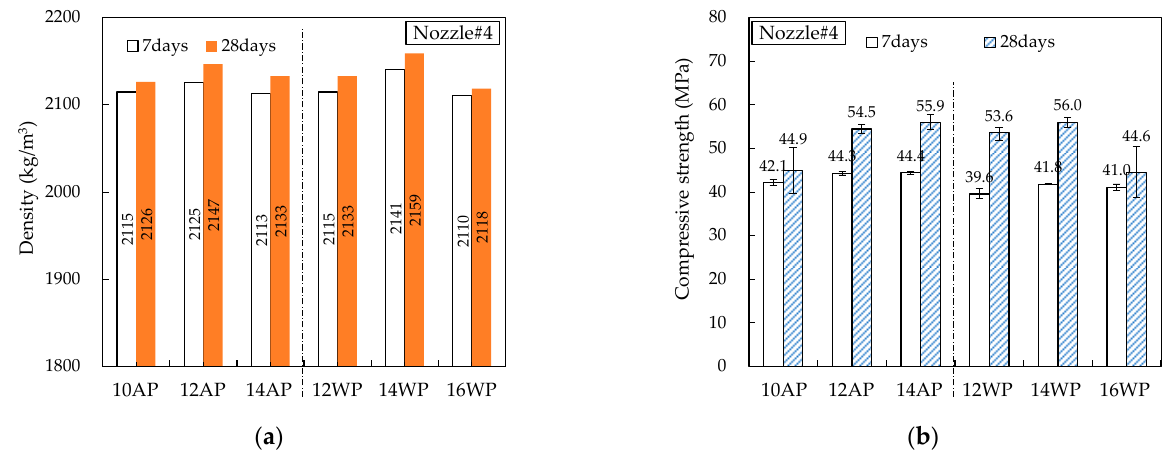
Figure 17. Hardened properties of Nozzle#4 specimens: ( a ) density; ( b ) compressive strength.